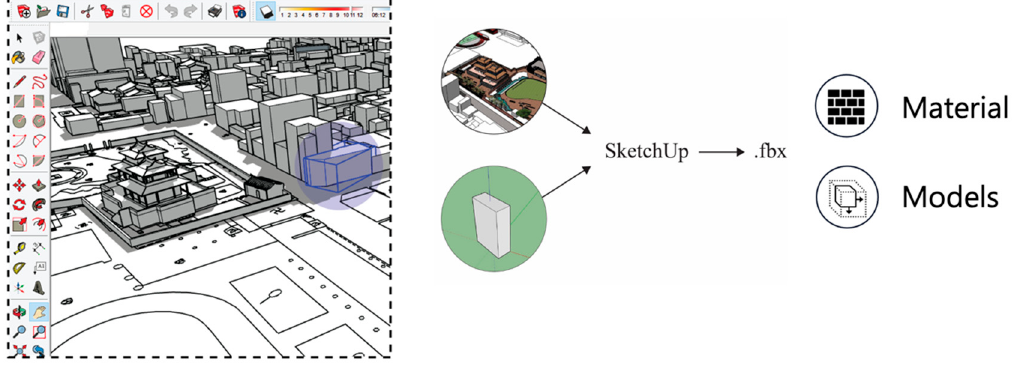
Figure 6. Concept map of the 3D old city block model.